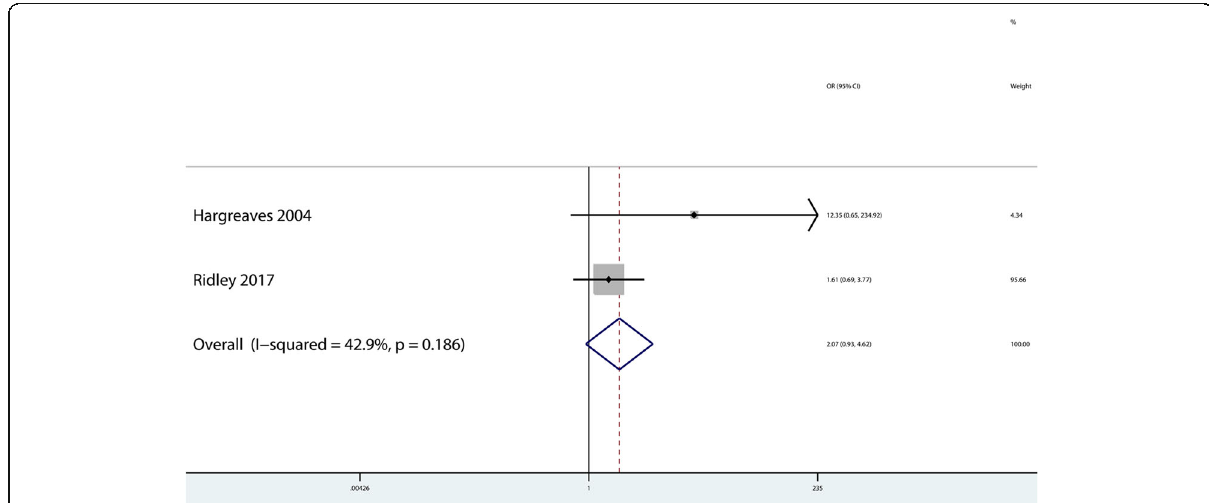
Fig. 5 Forest plot showing the rate of early pin removal comparing buried versus exposed Kirschner wire osteosynthesis for phalangeal, metacarpal and distal radial fractures